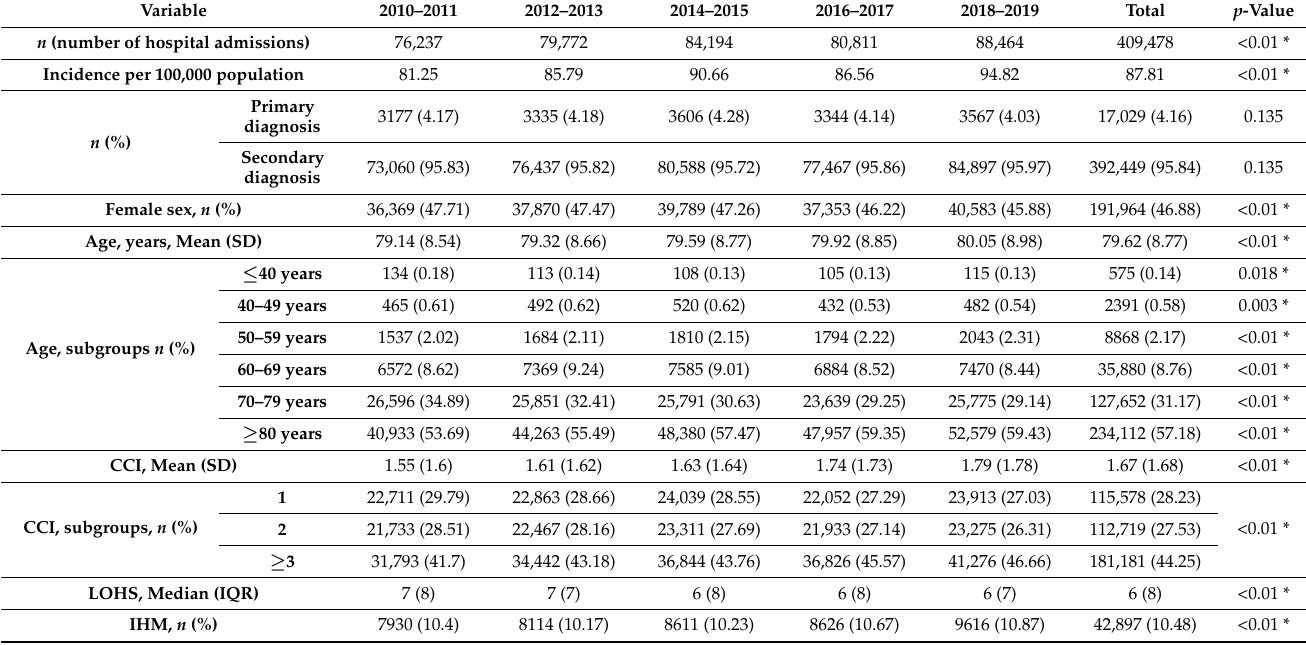
Table 1. Characteristics of Hospital Admissions of Parkinson ´ s Disease as a Primary or Secondary Diagnosis in Spain